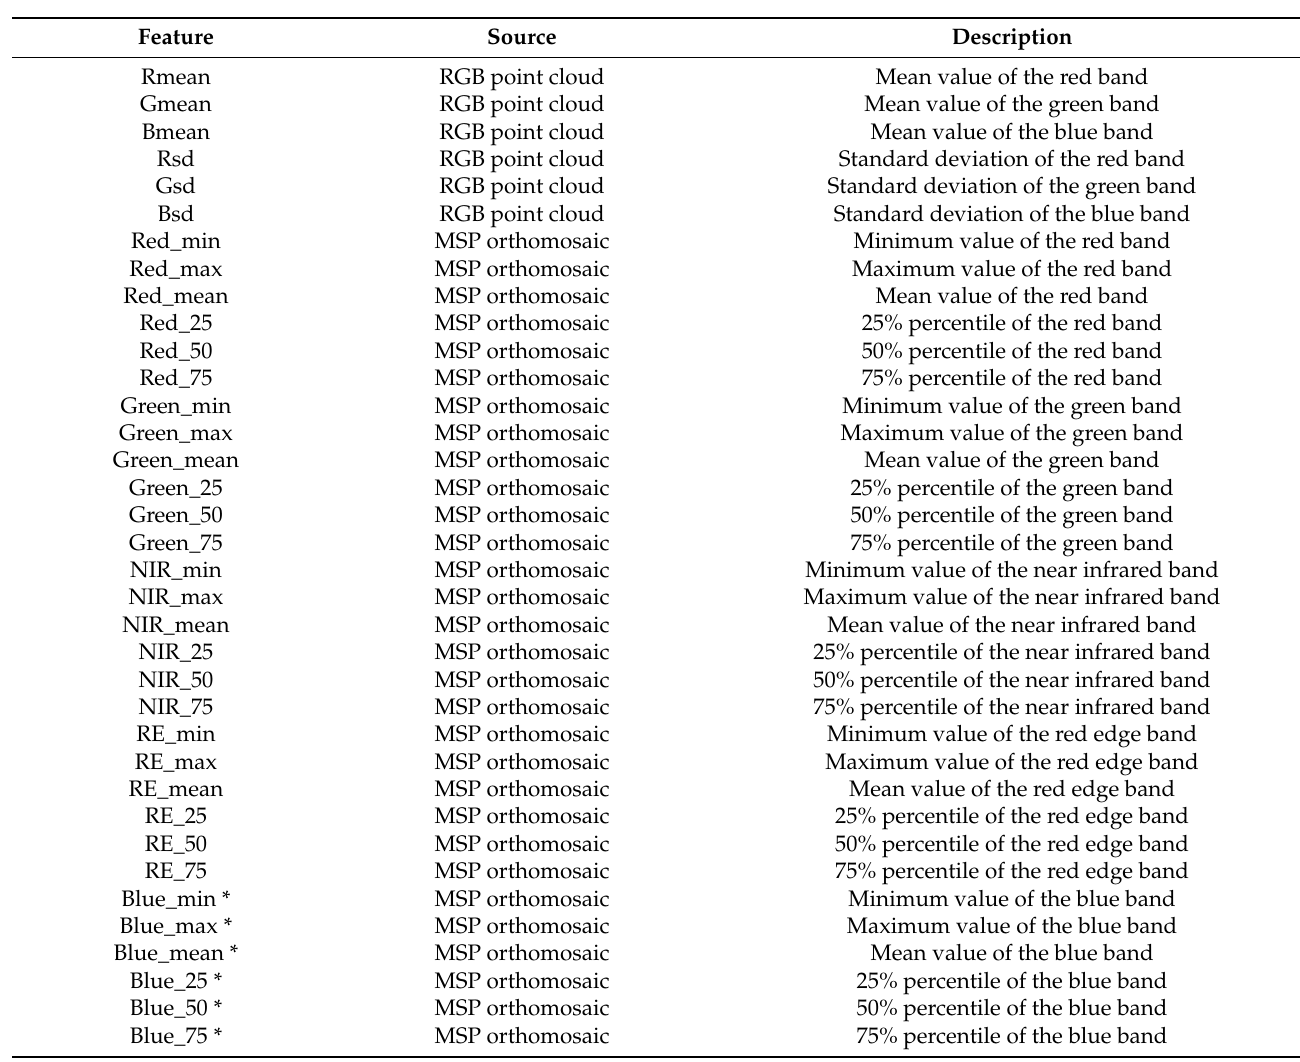
Table A2. Table of abbreviations of the spectral data